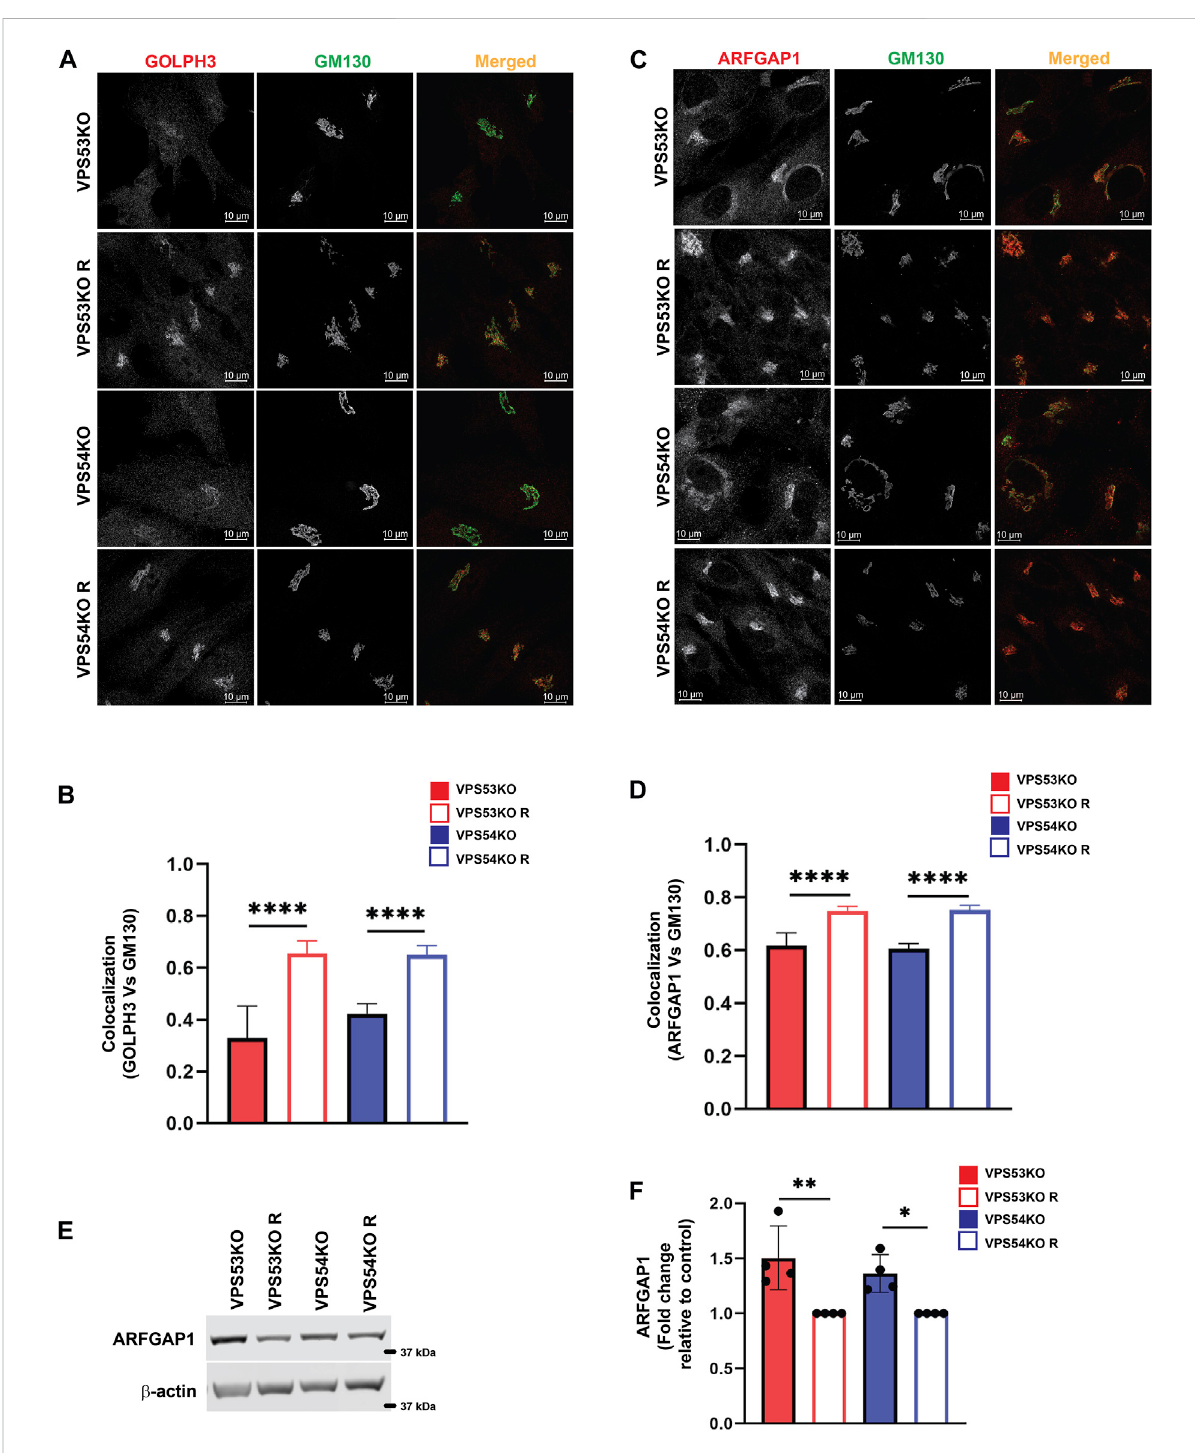
FIGURE 7 GARP dysfunction resulted in mislocalization of COPI adapter protein GOLPH3 and ARFGAP1 from the Golgi. (A) Airyscan microscopy of VPS53KO,VPS53KOR,VPS54KO,VPS54KORcellsstainedwithGOLPH3andGM130. (B) ColocalizationanalysisbetweenGOLPH3andGM130using Pearson ’ s correlation coef fi cient. n = 40 cells were used for colocalization analysis. (C) VPS53KO, VPS53KO R, VPS54KO, and VPS54KO R cells were stained for ARFGAP1 and GM130. (D) Colocalization analysis of ARFGAP1 and GM130 using Pearson ’ s correlation coef fi cient. n = 40 cells were usedforcolocalizationanalysis. (E) WBanalysis ofARFGAP1 totalproteinabundanceinGARP-KOandcontrolcells. (F) Quanti fi cationoftotalprotein abundance of ARFGAP1 in GARP-KOs and control cells. β -actin was used as internal loading control. **** p ≤ 0.0001, ** p ≤ 0.01, * p ≤